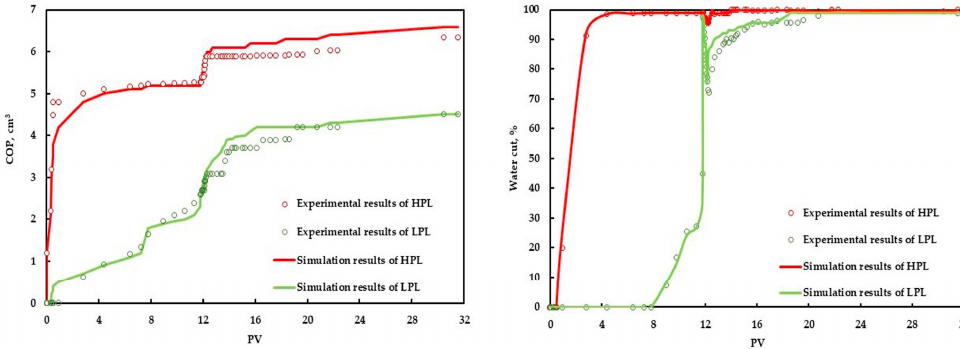
Figure 11. History matching results of the gel flooding experiment.